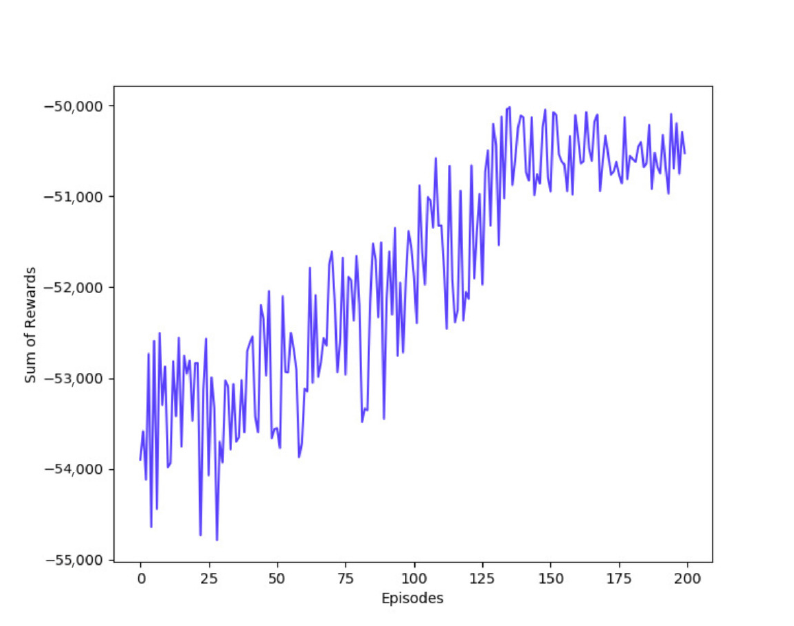
Figure 5. Sum of agent rewards during training.